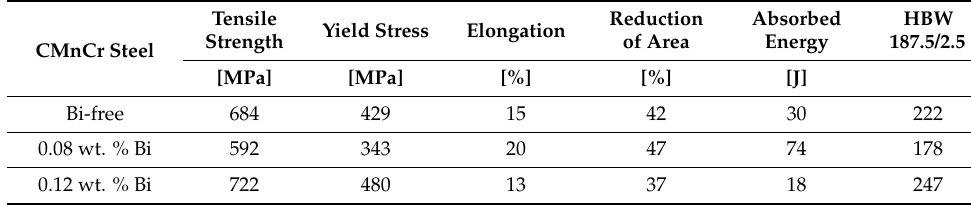
Table 2. Mechanical properties of CMnCr steels.